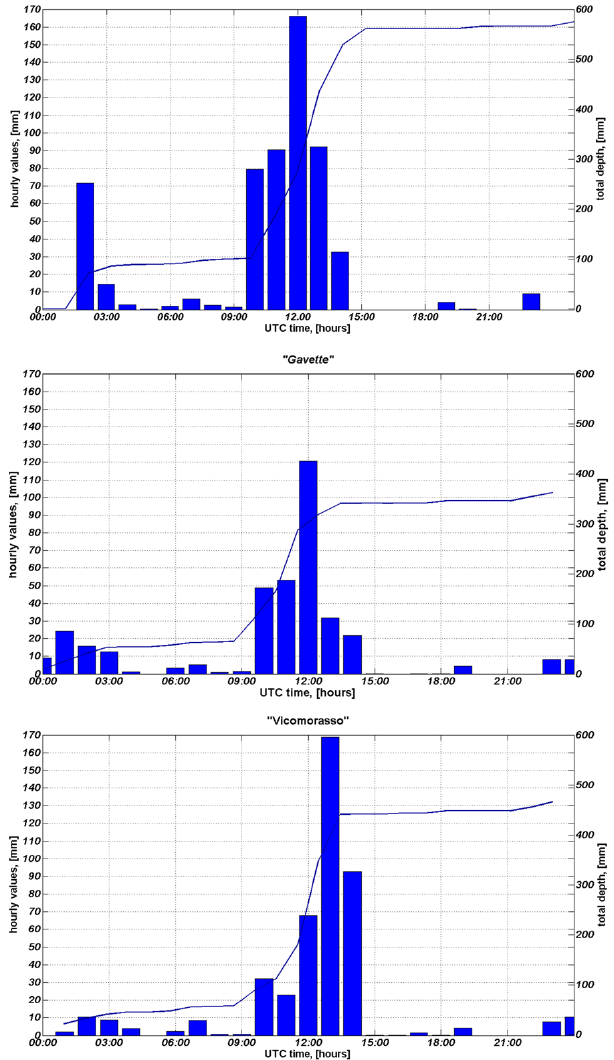
Fig. 6. On the top: rainfall event of the 4 November 2011, hyeto- graph of the personal weather station of LIMET network “Quezzi”. In the middle: hyetograph of the official weather station of ICPD